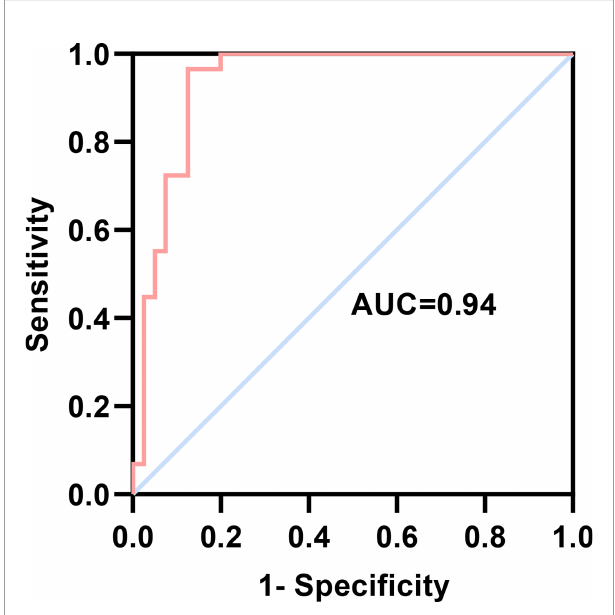
FIGURE 4 | ROC curve evaluation of the logistic regression model. The AUC of the predictive model was 0.94 (95% CI 0.87-1.00, P < 0.0001), with a sensitivity of 96.55% and a speci fi city of 87.50%. AUC, area under the curve; CI, con fi dence